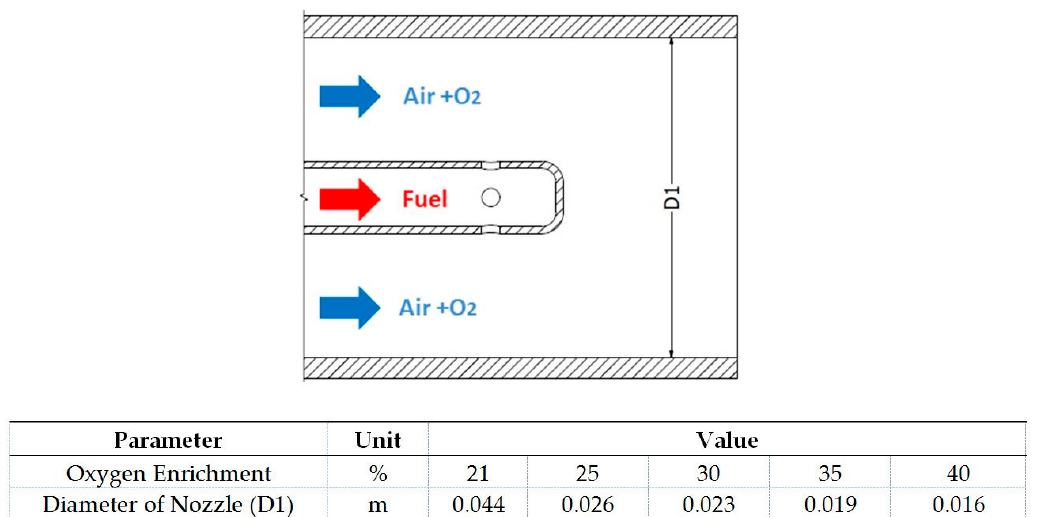
Figure 3. Burner modification parameters. Table 2. Flow rate of inlet media depending on oxygen concentration in the oxidizing agent. Concentration of Oxygen (% Vol.)